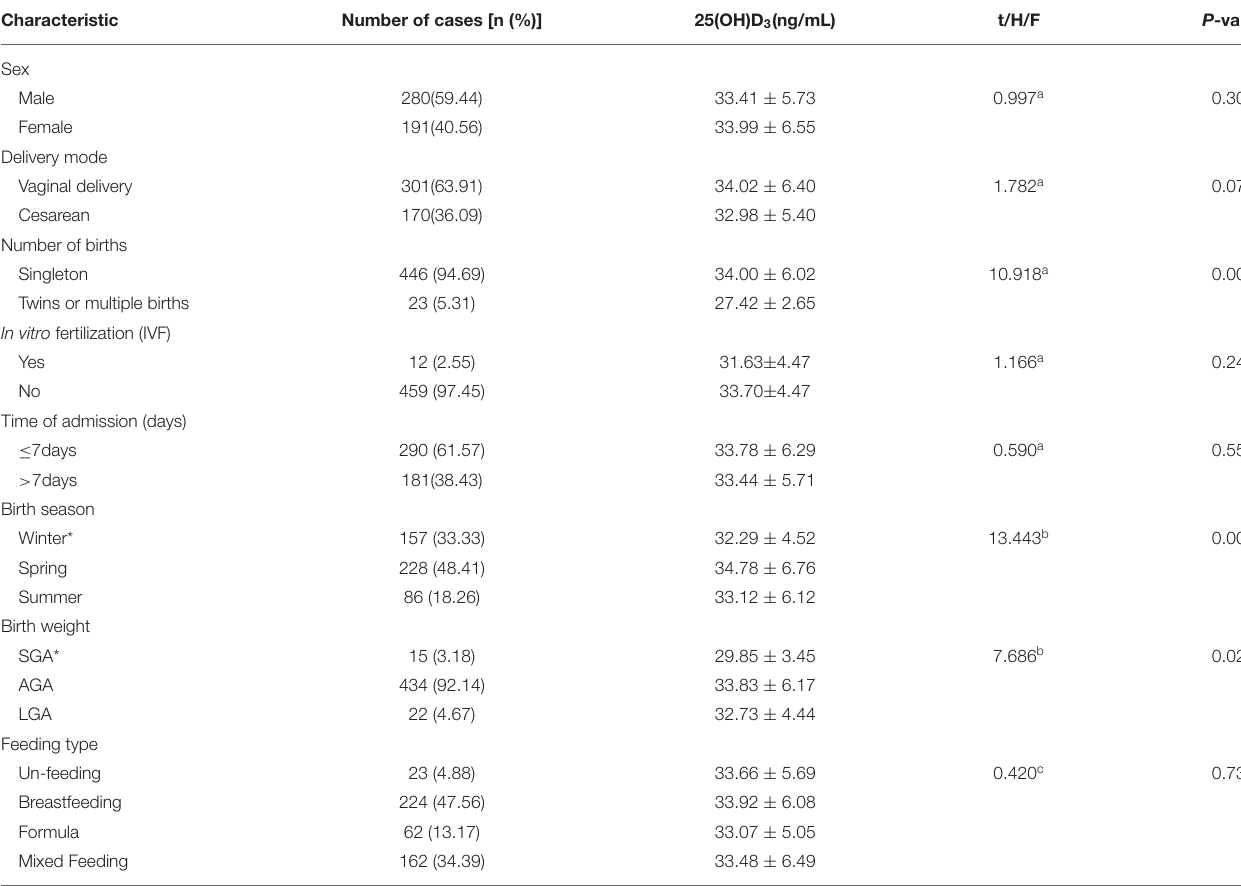
TABLE 1 | Patient characteristics and clinical